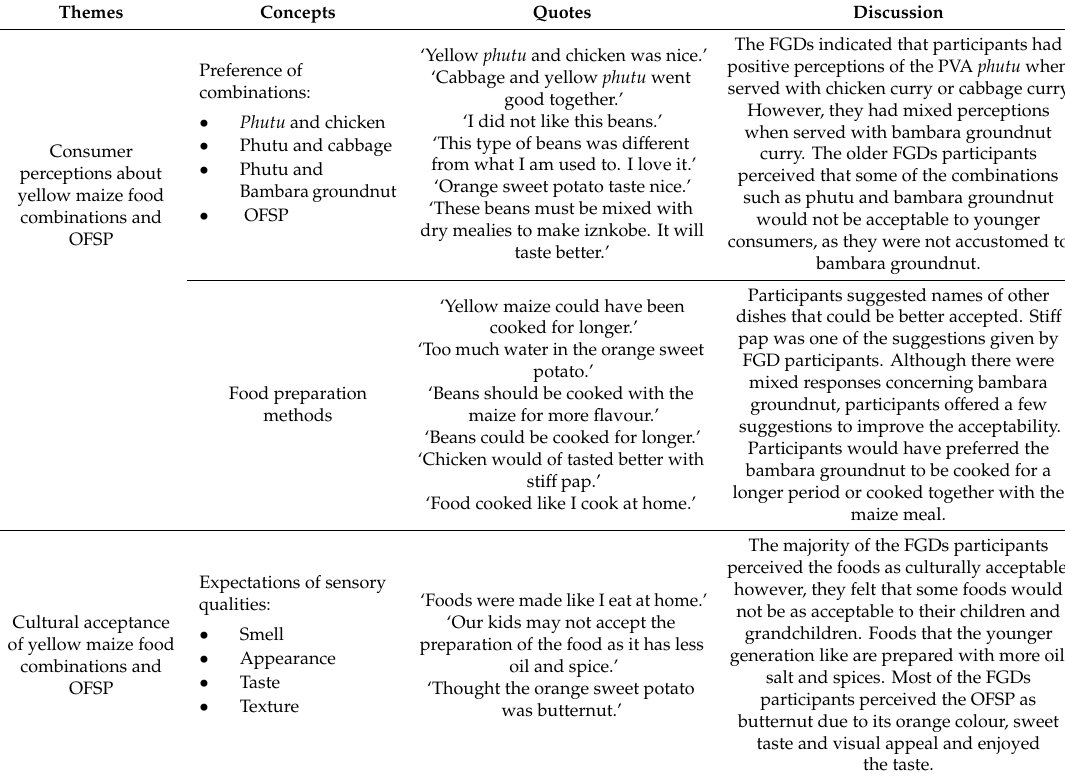
Table 12. Participants’ perceptions towards the consumption of OFSP and PVA-biofortified phutu with chicken curry, cabbage curry and bambara groundnut